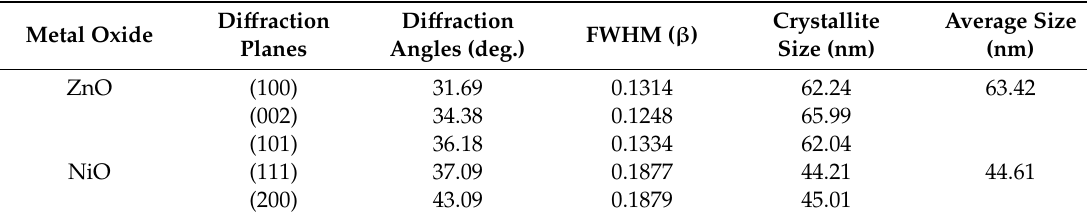
Table 1. Parameters for the calculation of crystallite